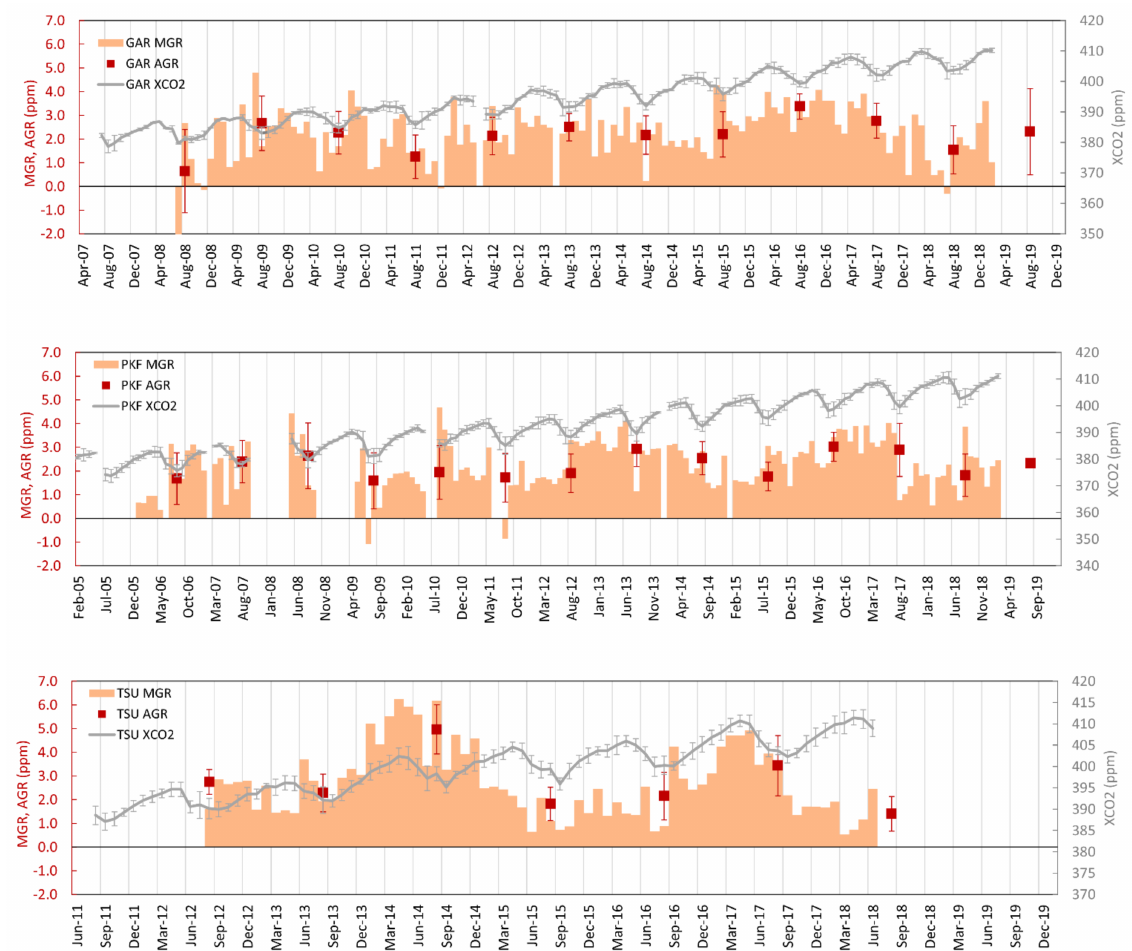
Figure 2. Time series of XCO 2 with monthly intervals (gray line), MGRs (orange bars), and AGRs (red squares) from GAR-Garmisch ( upper panel ), PKF-Park Falls ( middle panel ), and TSU-Tsukuba ( bottom panel ) stations. X-axis is plotted according to the data abundance of each station for better illustration of MGR data. AGR points (red squares) are plotted versus August of the corresponding year projected at the x-axis (they are assumed to be representative for a given year). XCO 2 error bars are calculated according to sub-monthly XCO 2 variations, AGR error bars are plotted according to sub- annual variability of MGR. MGR error bars are omitted for better readability of the plot and because MGR error bars stem from monthly XCO 2 standard